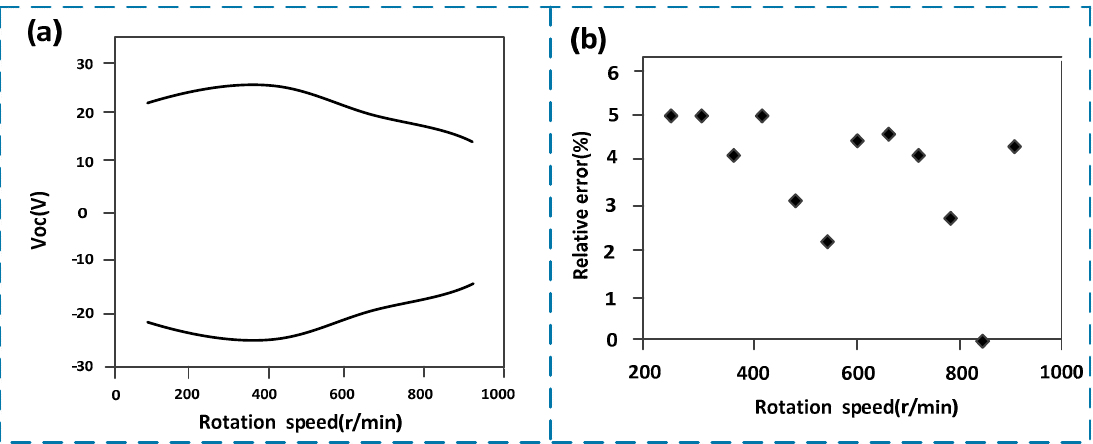
Figure 4. Statistical analysis results of the measured data under different rotational speeds. ( a ) Signal voltage amplitude of the sensor under different rotational speeds; ( b ) scatter diagram of relative error of the measured rotational